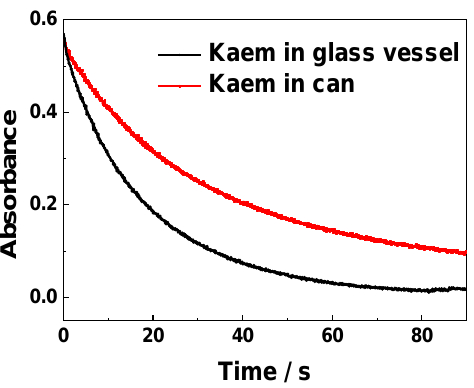
Figure 8. Time evolution of absorbance at 517 nm for 50 μM DPPH • scavenged by 100 μM HKaem in ethanol stored for 48 h in glass vessel and in a Sn can.